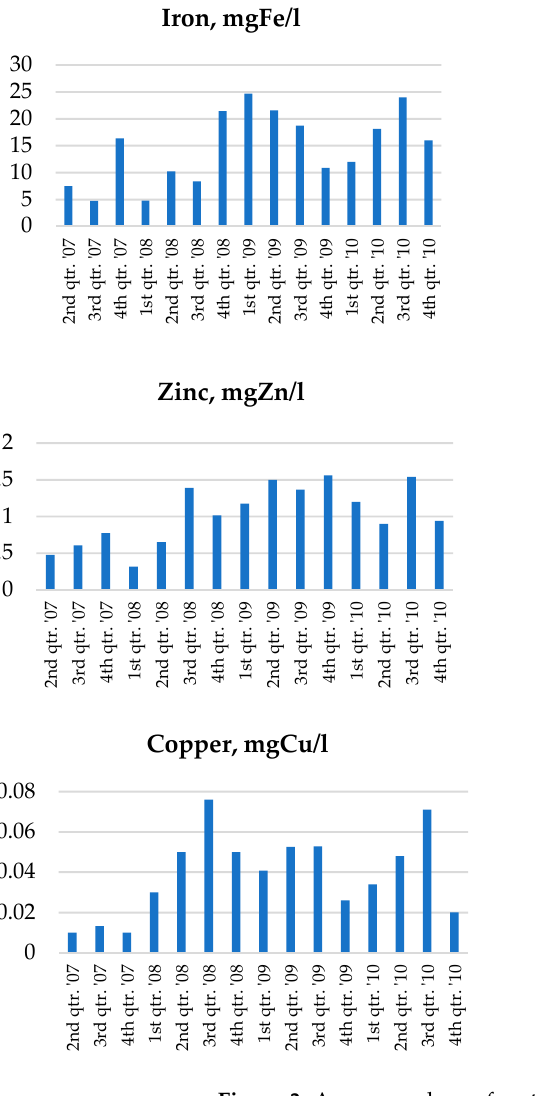
Figure 3. Average values of metallic elements in water collected from piezometers P 12, P 15, P 16, P 17 (April 2007 to December 2010).